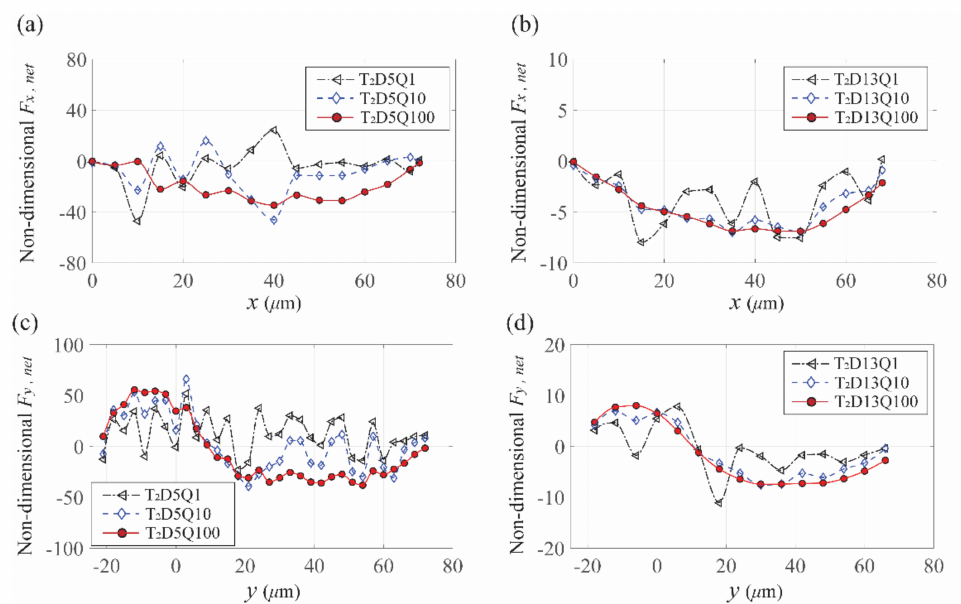
Figure 9. Variation in ( a , b ) x-directional and ( c , d ) y-directional net elasto-inertial force exerted on 5 and 13 µ m particles suspended in the Type 2 channel. Measurements were made for various particle locations along the x and y axis illustrated in Figure